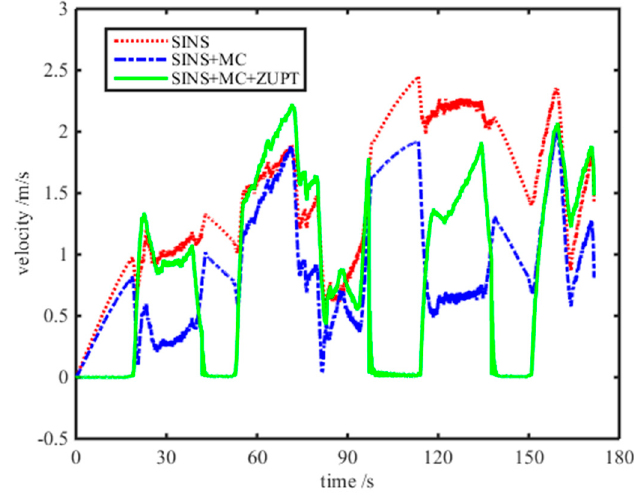
Figure 11. Velocity result of the SINS with different algorithms.